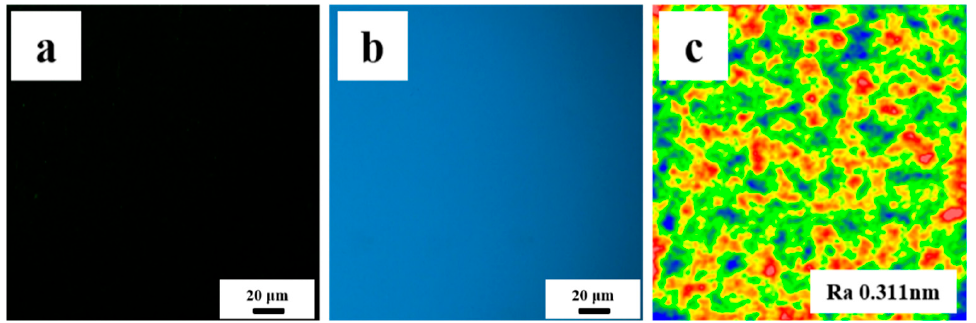
Figure 9. Initial surface quality of samples ( a ) dark field image; ( b ) bright field image; and ( c ) typical roughness distribution diagram.